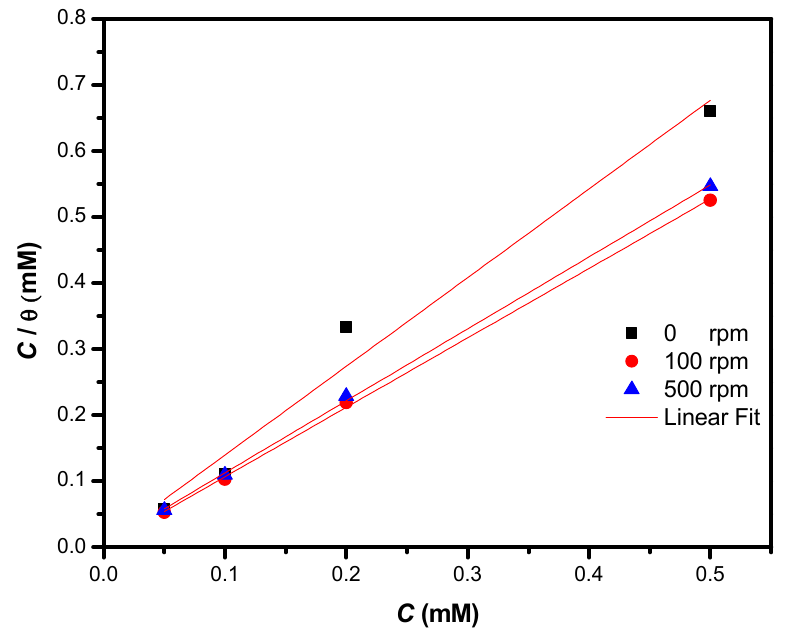
Figure 10. Adsorption isotherm of 4-PC immersed in 3% NaCl + CO 2 in 1018 steel at different rotation rates. Table 2. Thermodynamic analysis of 4-PC immersed in 3% NaCl + CO 2 in 1018 steel at different rotation rates by means of the Langmuir model.